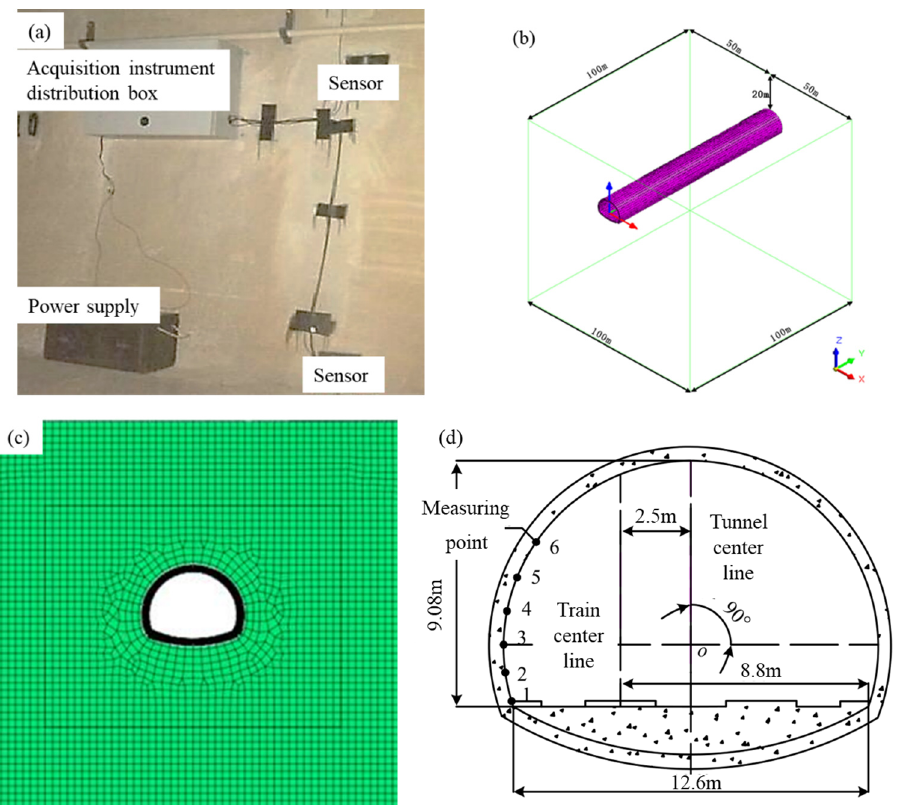
Figure 3. Comparison between field tests and corresponding numerical models: ( a ) Field measuremen; ( b ) Numerical model; ( c ) Local model grid; ( d ) Schematic diagram of measuring point layout.